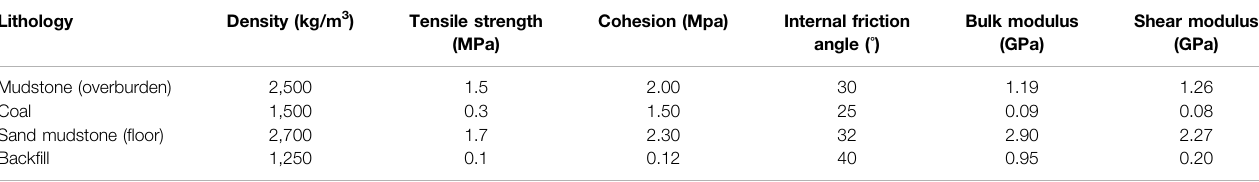
TABLE 5 | Physical and mechanical parameters of the model in numerical